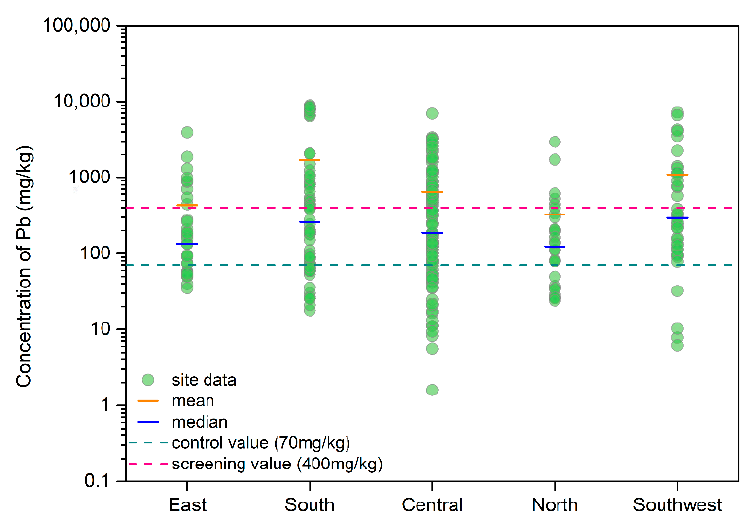
Figure 2. Regional distribution of Pb concentrations (East region includes Zhejiang, Anhui, Shanghai, Jiangxi, Shandong, Jiangsu and Fujian provinces. South region includes Guangxi, Guangdong and Hainan provinces. Central region includes Hunan, Hubei and Henan provinces. North region includes Shanxi, Shaanxi, Hebei, Beijing, Tianjin, Inner Mongolia, Jilin, Heilongjiang and Liaoning provinces. Southwest region includes Yunnan, Guizhou, Chongqing and Sichuan provinces).